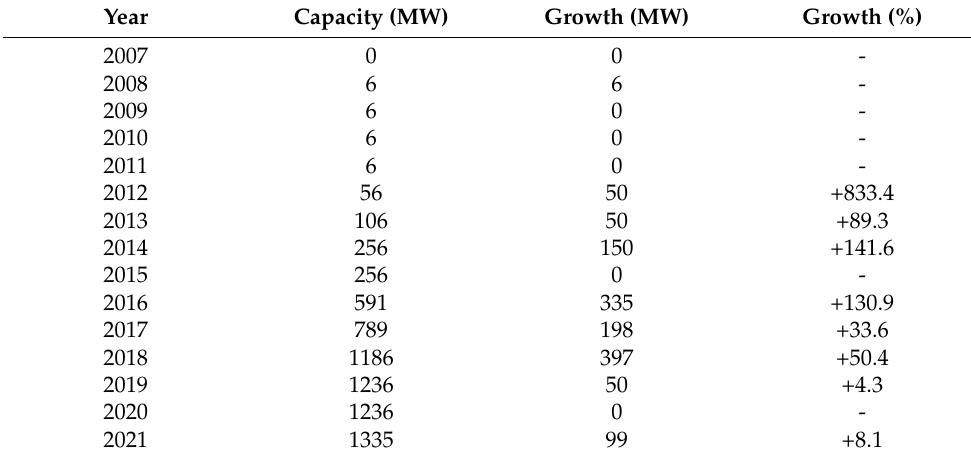
Table 1. Annual production capacities and growth of wind power in